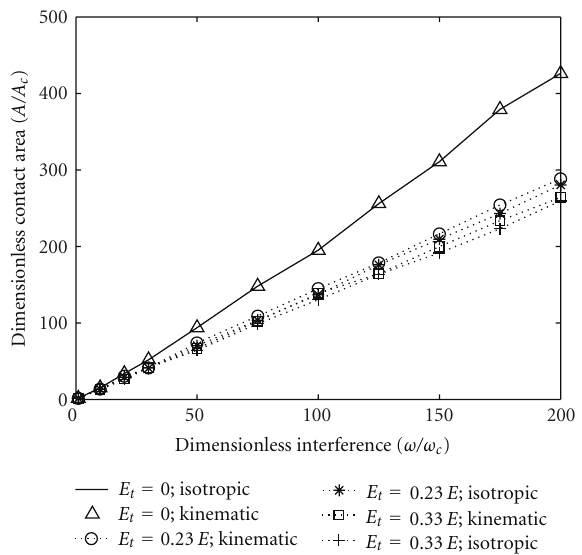
Figure 10: Dimensionless contact area against dimensionless inter- ference for kinematic and isotropic material hardening.